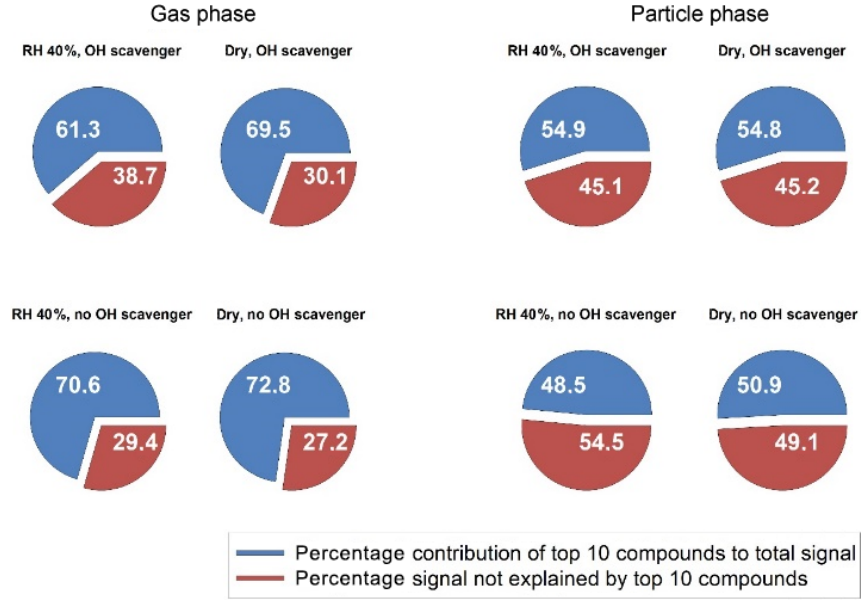
Figure 3. Contribution of the highest 10 compounds (blue) to the total signal in the gas and particle phase. The red fraction shows the signal not explained by the 10 highest compounds. Thus, a larger red fraction indicates a more complex composition. Data are shown for selected experiments with 1000ppb ozone and 150ppb limonene under different conditions. The estimated total yield of larger carboxylic acids (C 7 –C 10 ) for these four experiments were very similar: 6% (dry, scavenger), 8% (humid, scavenger), 6% (dry, no scavenger) and 7% (humid, no scavenger).